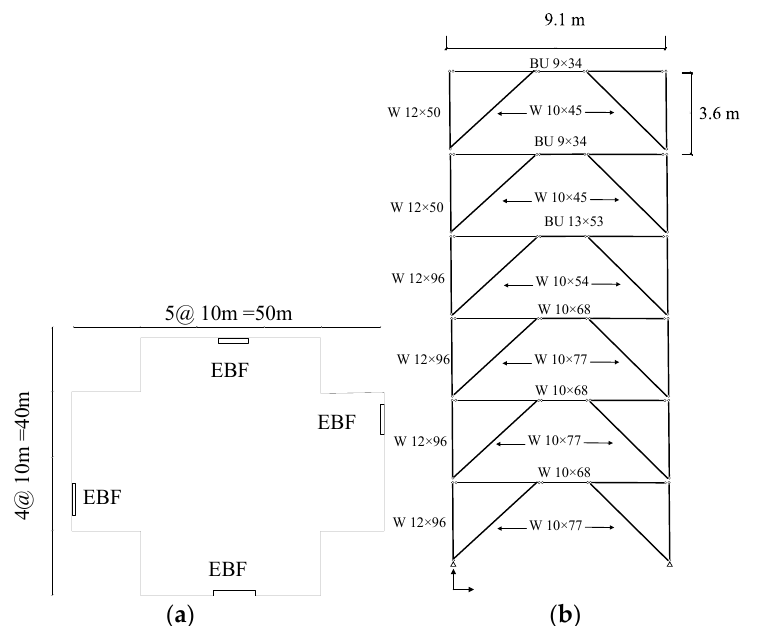
Figure 8. The SEAOC example for EBF system with six stories ( a ) The plan view of the structure with EBF system shown on the perimeter of the building (SEAOC, 2012) ( b ) The six story EBF system with columns, beams and braces sectional properties.